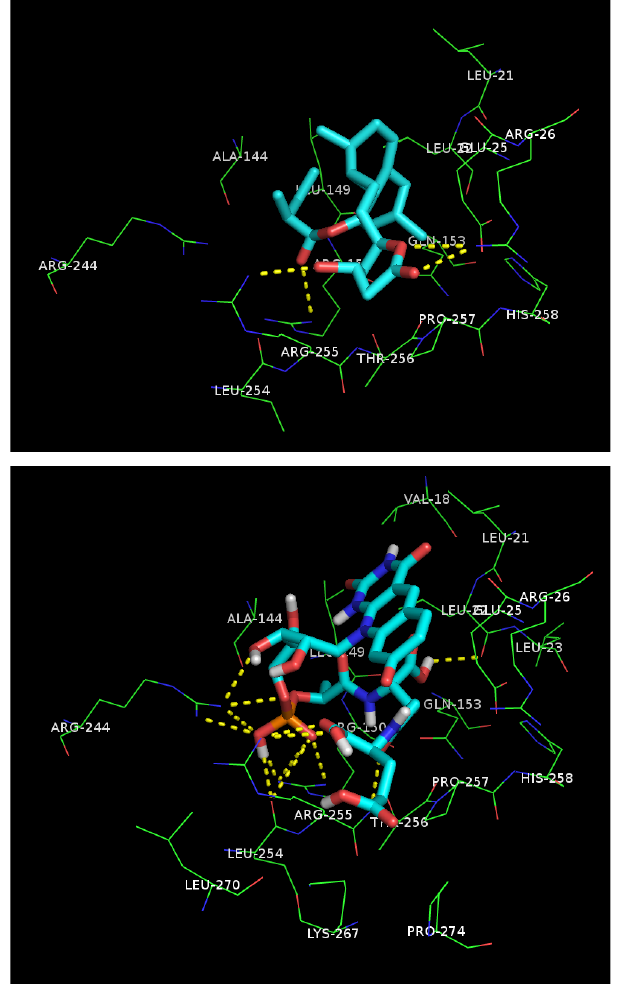
Figure 3. Lovastatin-lactone 1: (top) [Calculated affinity: -7.2 (kcal/mol); AutoDock4.1Score: 14.3]; 2: (bottom) F420 [Calculated affinity: -6.99 (kcal/mol); AutoDock4.1Score: 63.3] docked into A5UMI1_3IQZB_SiteSeeker2. Hydrogen bond interactions are denoted with yellow dotted